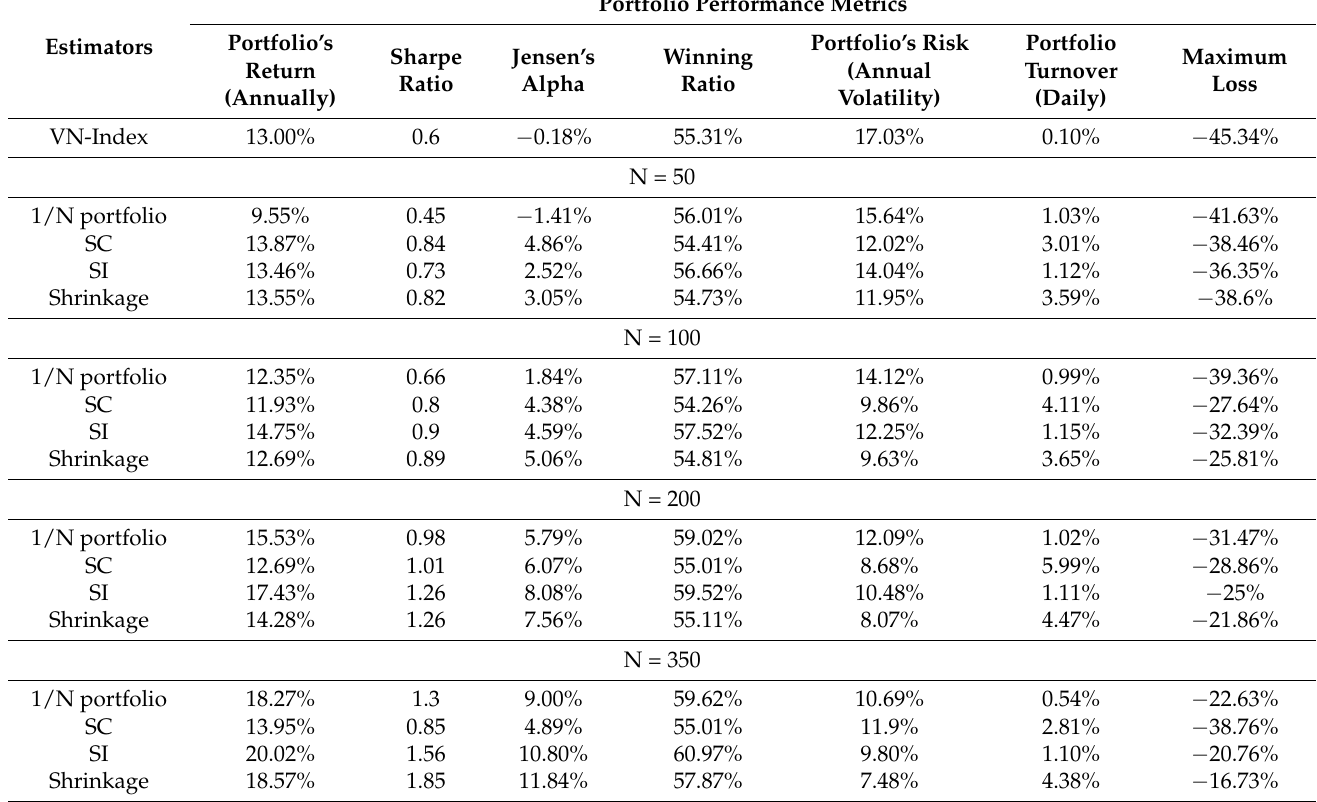
Table 1. The performance of different estimators on out—of—sample from 1 January 2013–1 January